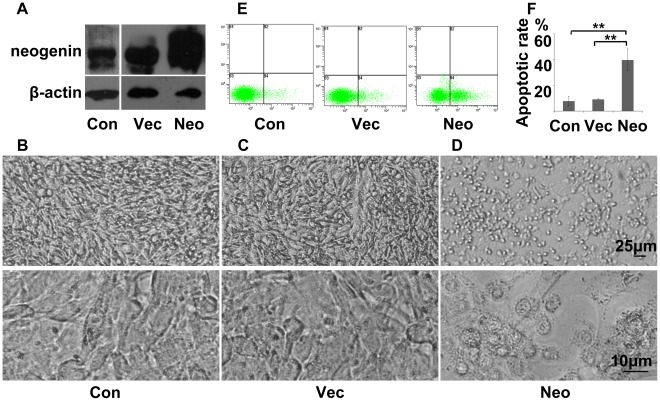
Overexpression of neogenin in SHG-44 cell line.(A) Western blot results showed neogenin expression in the blank control which was untreated (Con), the negative control which was transfected by empty vector (Vec) and the over-expressive group which was transfected by neogenin expression plasmid (Neo) in SHG-44 cell line at 48 hours after transfection; (B-D) Status of cells in the blank, negative and over-expressive group of neogenin respectively at 48 h after transfection. (E) Apoptotic distribution maps of cells in the blank, negative and over-expressive group were drew by flow cytometry assay respectively. (F) Average apoptotic rate of cells in the blanck, negative and over-expressive group in the flow cytometry assay, One-Way ANOVA, n = 3, **p<0.01, error bars indicate standard error means.